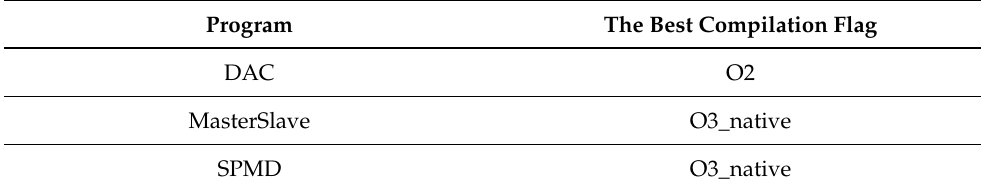
Table 6. The best compilation flag for each